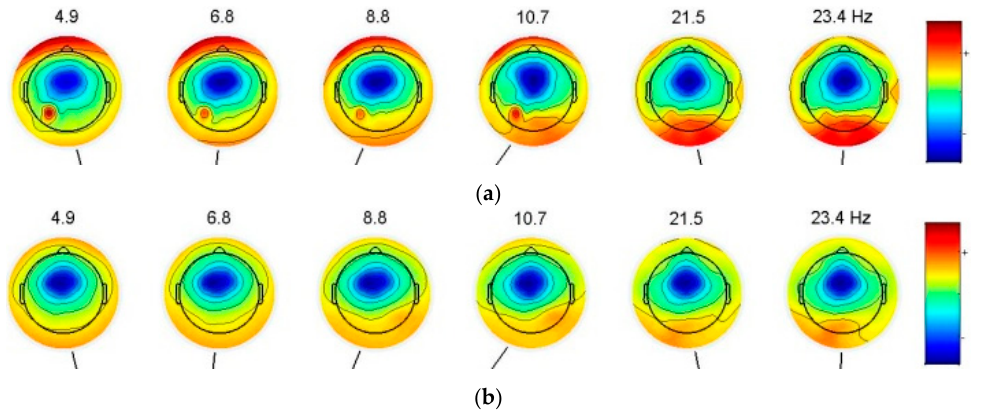
Figure 8. Power scalp topographies of various frequency components. ( a ) power scalp topographies in alertness; ( b ) power scalp topographies in drowsiness.